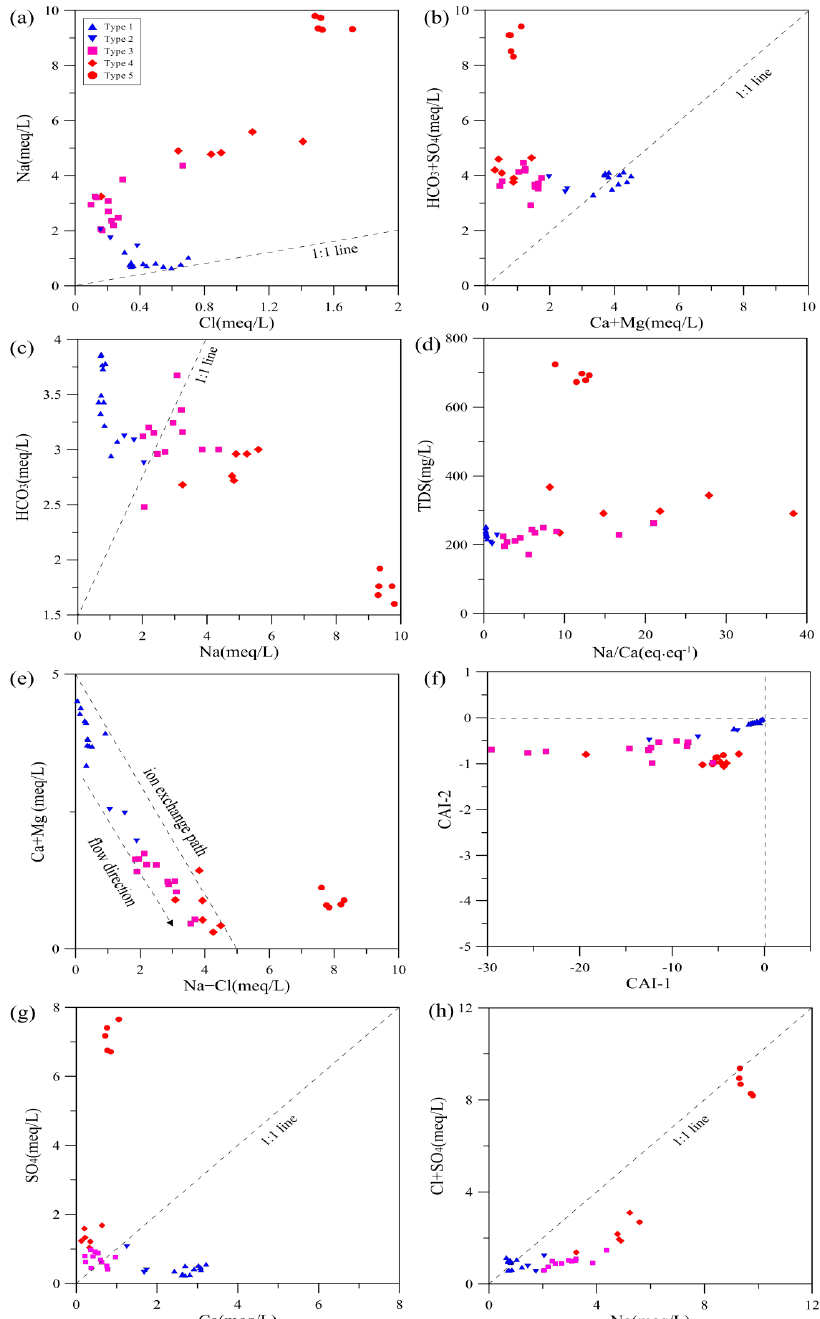
Figure 9. The plots of the correlations among different ions (and their ratios and indices) for the five water types: relationships between ( a ) Cl and Na; ( b ) (Ca + Mg) and (HCO 3 + SO 4 ); ( c ) Na and HCO 3 ; ( d ) Na/Ca ratios (eq·eq − 1 ) and TDS; ( e ) (Na − Cl) and (Ca + Mg); ( f ) CAI-1 and CAI-2 (CAI is the abbreviation for the Chloro-Alkaline indices); ( g ) Ca and SO 4 ; and ( h ) Na and (SO 4 + Cl).